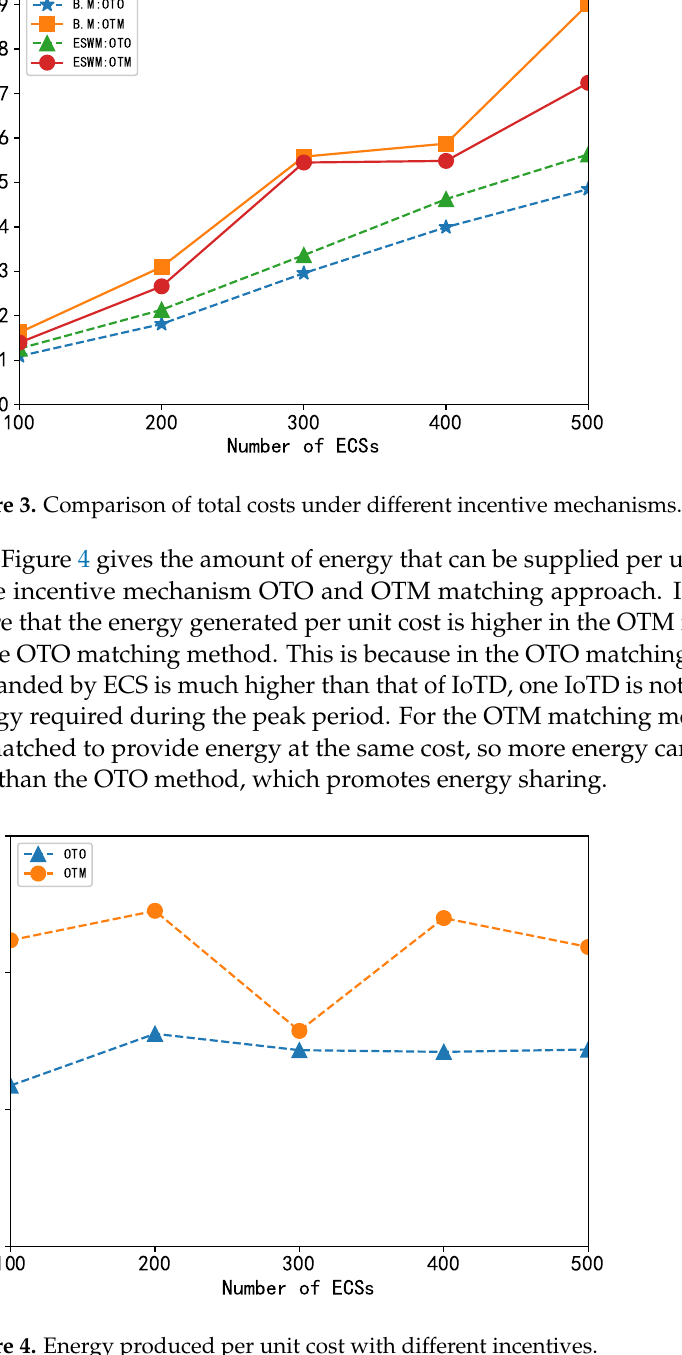
Figure 4. Energy produced per unit cost with different